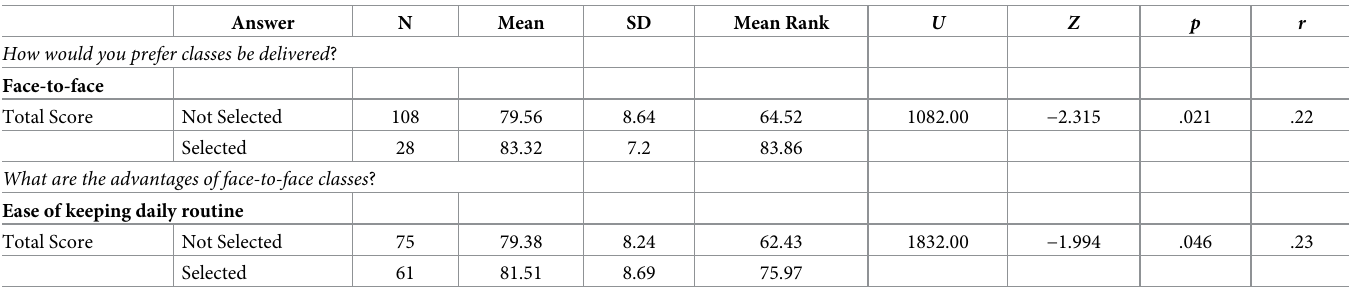
Table 3. Results of comparison of CBT score between students who selected answers listed below and students who selected